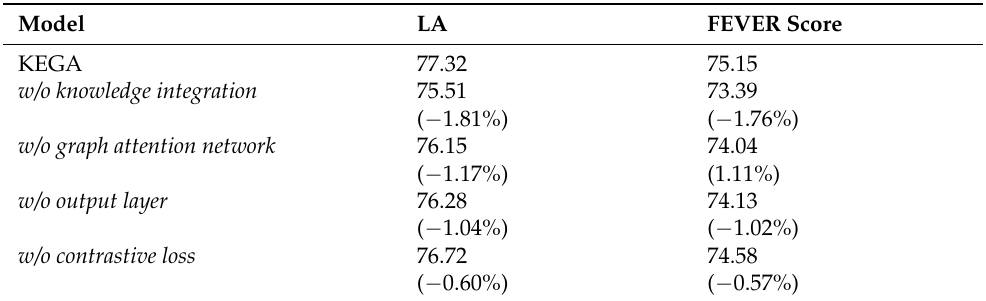
Table 4. Results in terms of label accuracy and FEVER Score of KEGA without different modules on the development set (%). Model